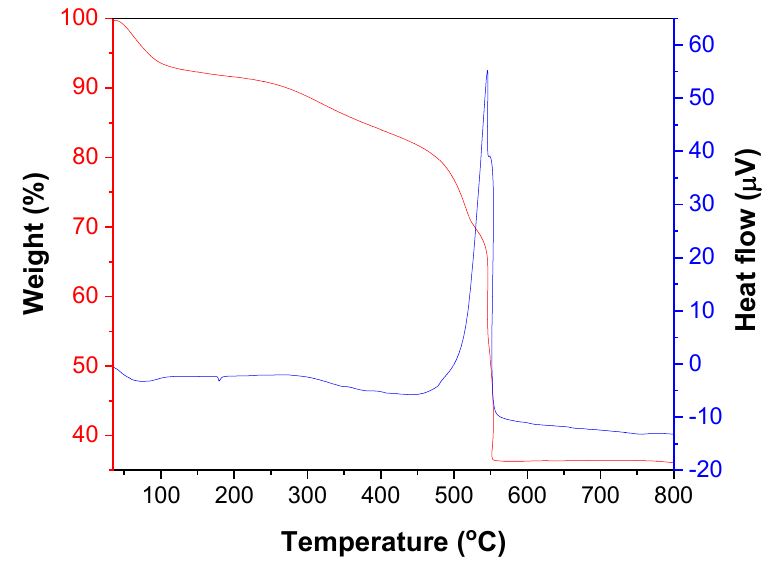
Figure 4. TG/DTA of CNTs-Ag 2 S.